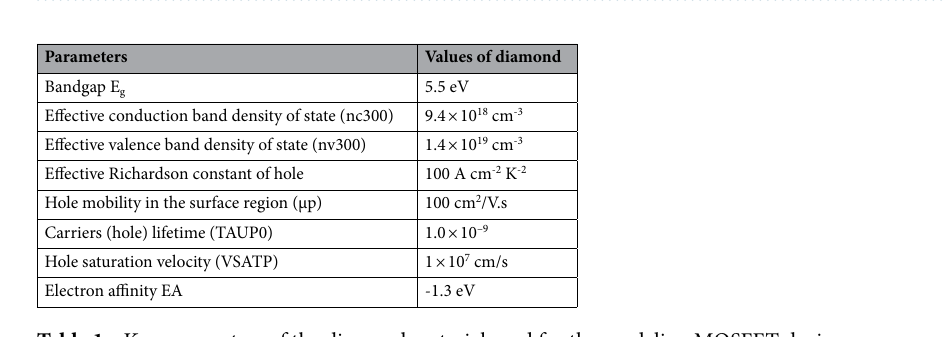
Table 1. Key parameters of the diamond material used for the modeling MOSFET